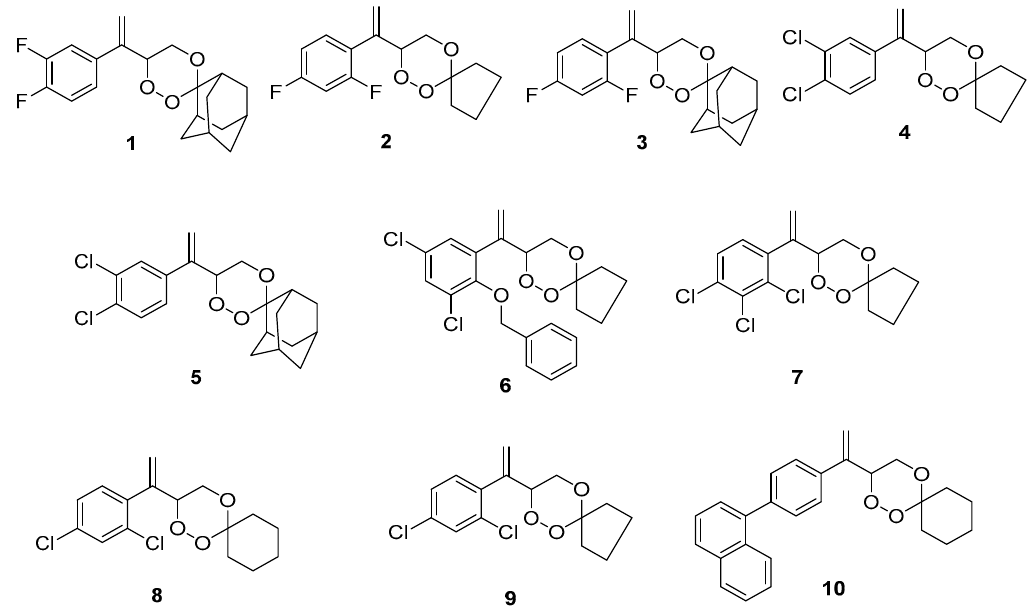
Figure 2. Structures of 1,2,4- trioxanes 1 – 10 prepared for this study.